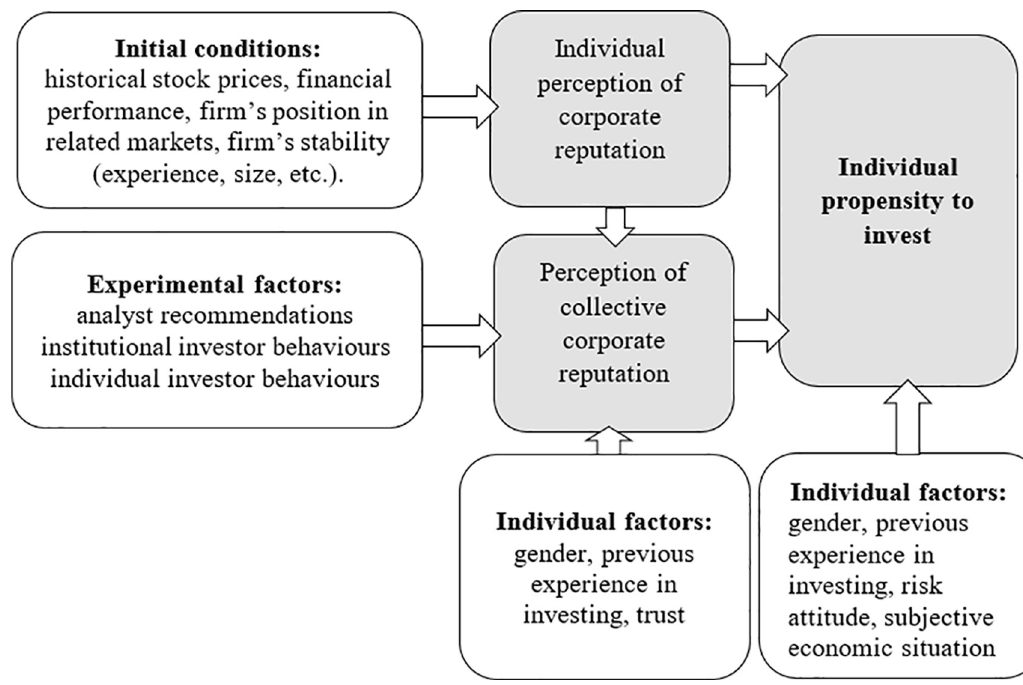
Fig 1. Experimental design: A conceptual